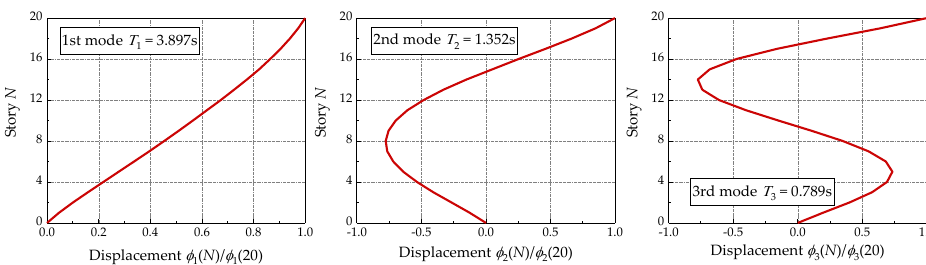
Figure 6. The modal information of the considered benchmark frame.